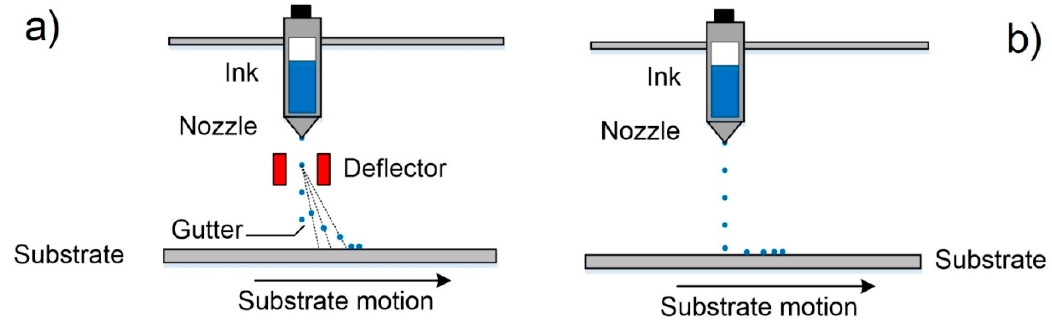
Figure 4. Schematic diagrams of printing methods used in Inkjet printing: ( a ) continuous inkjet (CIJ); ( b ) drop-on-demand (DOD).